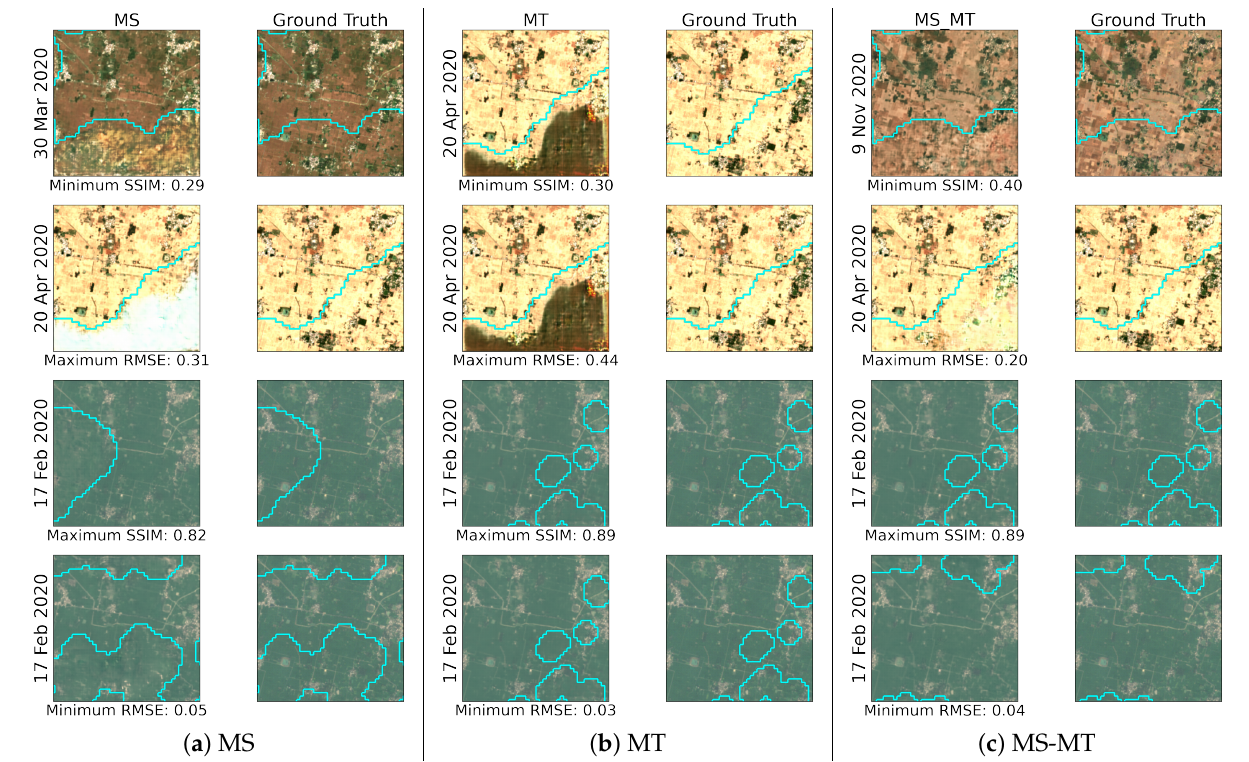
Figure 10. Reconstructions with the lowest (top two rows) and highest (bottom two rows) perfor- mance for both the SSIM and RMSE for the India region. Each row contains all three stacked modes (MS, MT, and MS-MT).